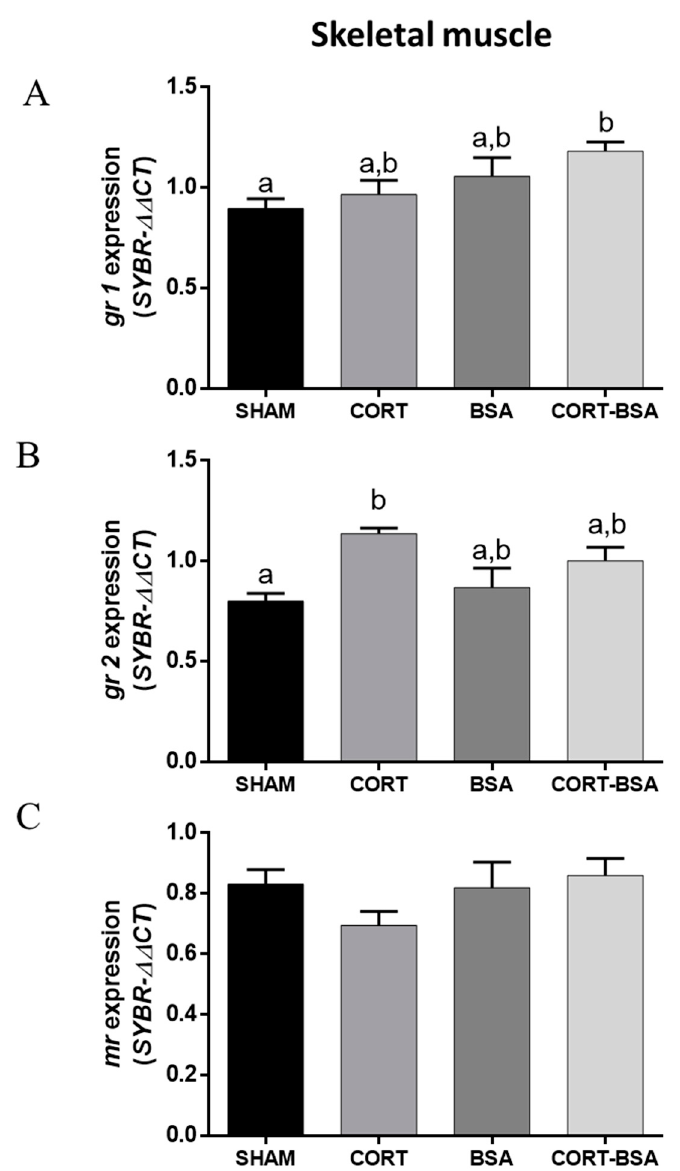
Figure 3. Corticosteroid-receptors gene expression in skeletal muscle. Results of gr1 ( A ), gr2 ( B ) and mr ( C ) expression in vehicle (sham-control), cortisol, BSA and cortisol-BSA administered fish at 72 h post-treatment. Results are expressed as mean ± SEM ( n = 8). Different letters indicate significant differences between groups ( p value < 0.05). All data were analyzed using one-way ANOVA and Tukey’s HSD as a post-hoc test.